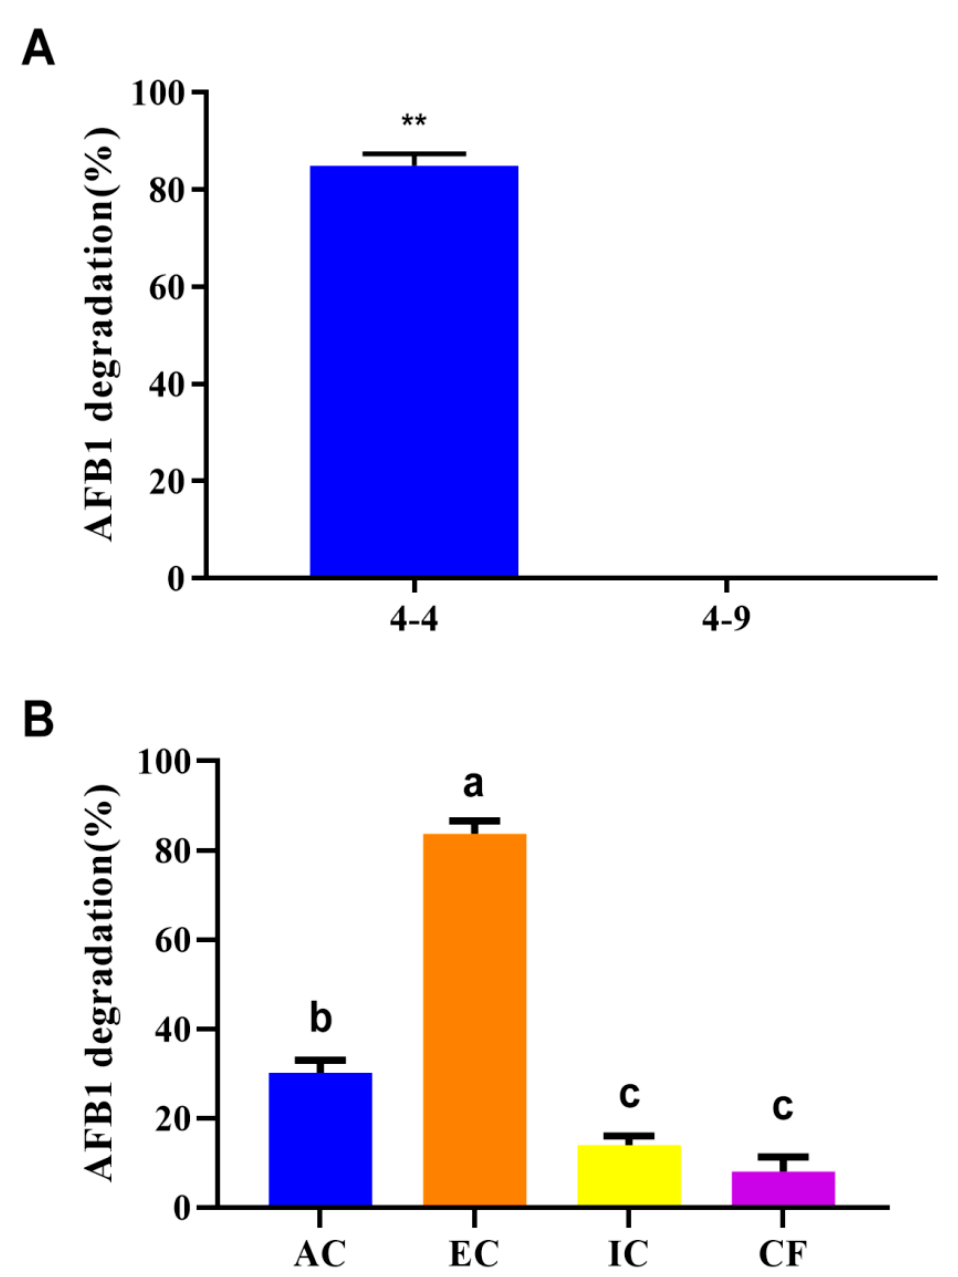
Figure 1. Characterization of the AFB 1 degradation ability of R. pyridinivorans 4-4. ( A ) AFB 1 degrada- tion ability of Rhodococcus strains. ( B ) AFB 1 degradation by different fractions of R. pyridinivorans 4-4. AC: active cell components; EC: extracellular component; IC: intracellular component; CF: cell fragments. Data are shown in means ± SEM. Significant ( p < 0.01) difference between pairwise comparison is depicted by a double asterisk (one-way ANOVA). Values sharing the same letter are not significantly different at p < 0.05 (one-way ANOVA and Duncan’s multiple range test).